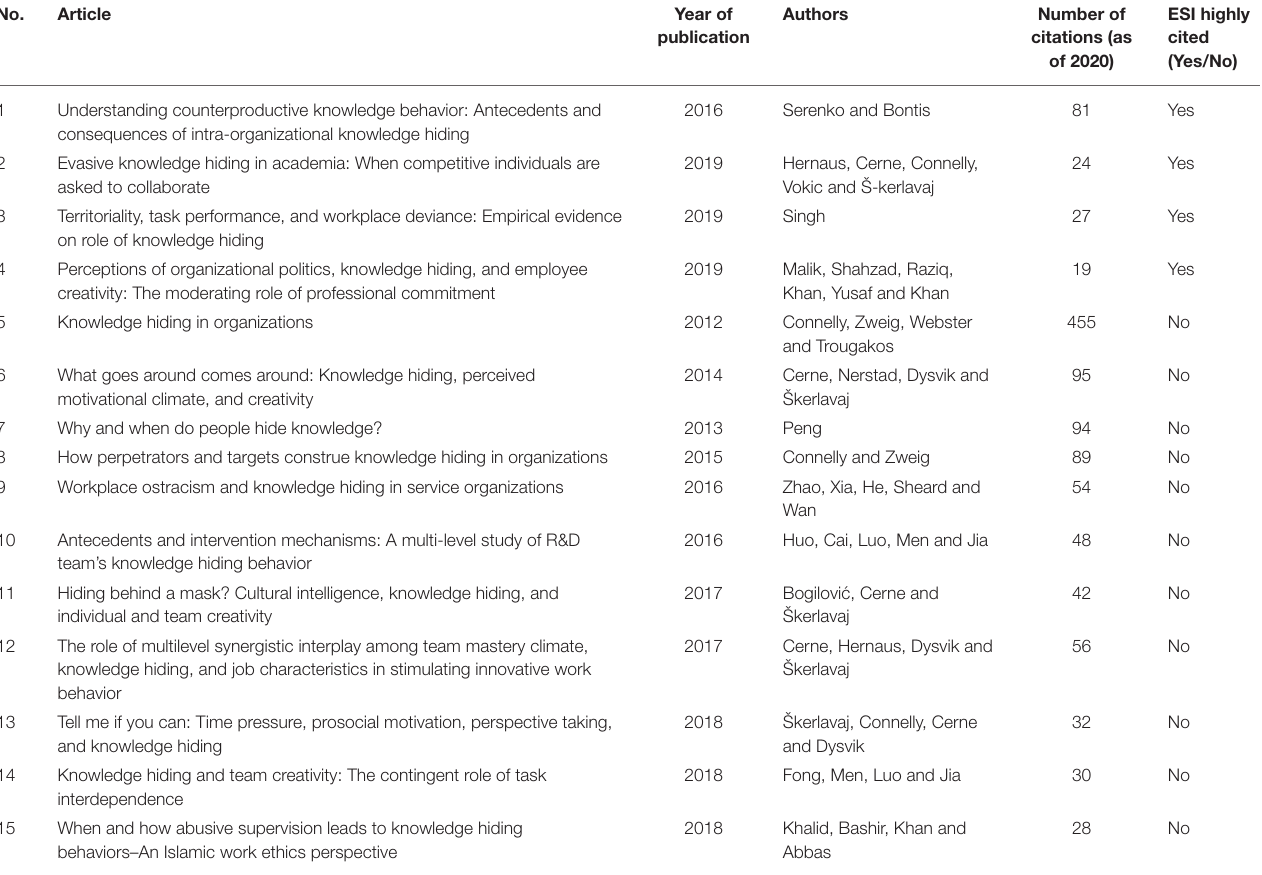
TABLE 5 | Top 15 articles on knowledge hiding by the number of citations.